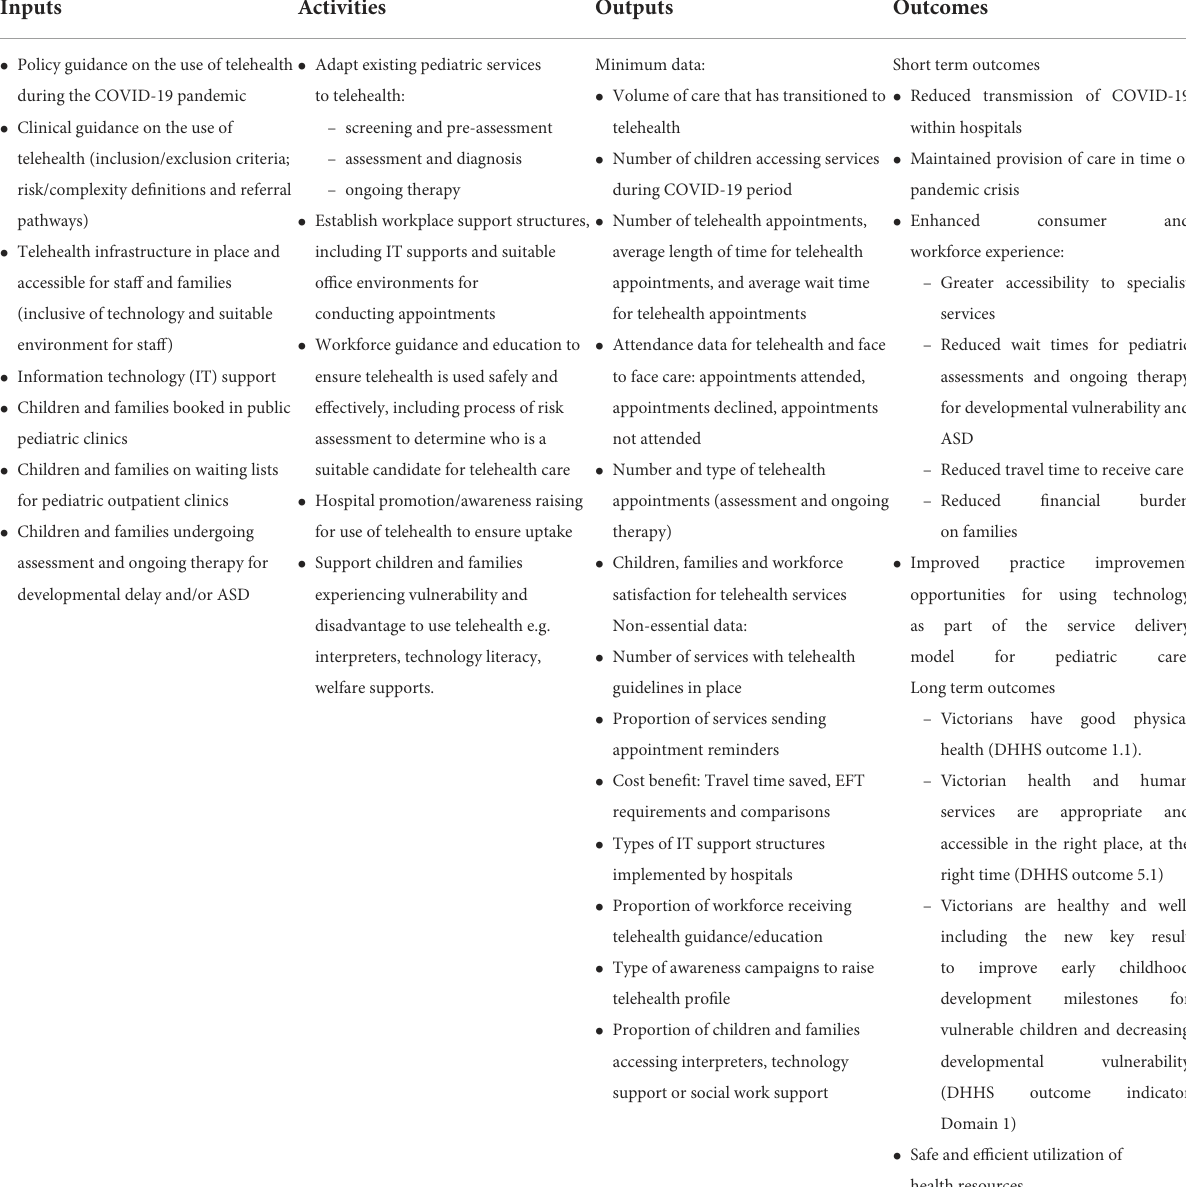
TABLE 4 Programme logic model for the use of telehealth in pediatric care. Inputs